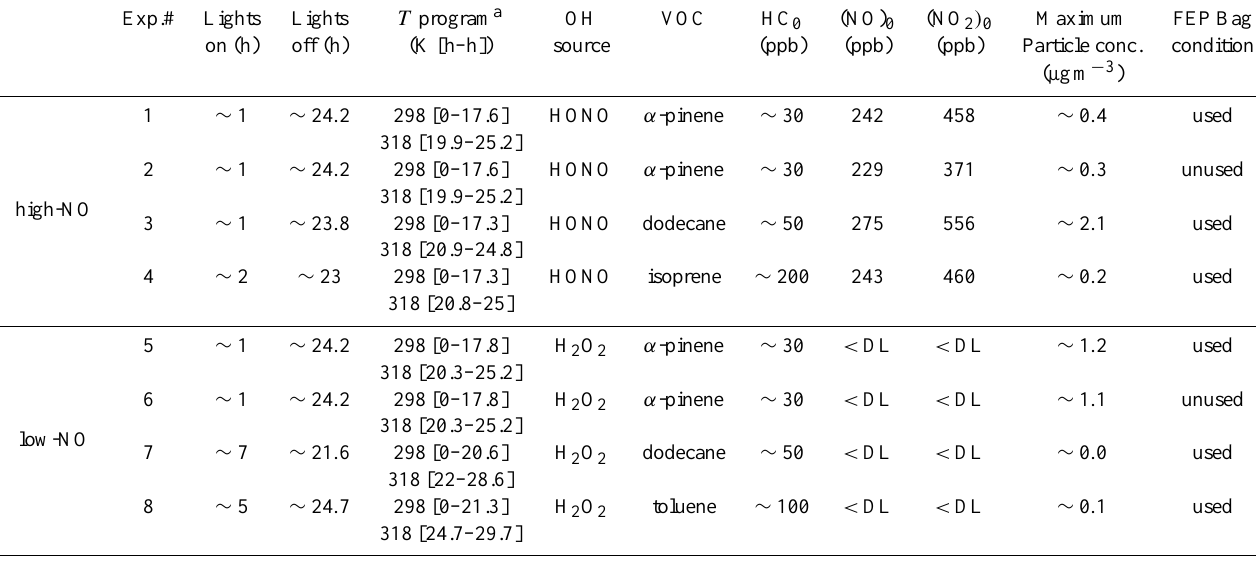
Table 1. Experimental conditions for production of oxidized organic vapors. Exp.# Lights Lights T program a OH VOC HC 0 (NO) 0 (NO 2 ) 0 Maximum FEP Bag on (h) off (h) (K [h–h]) source (ppb) (ppb) (ppb) Particle conc. condition